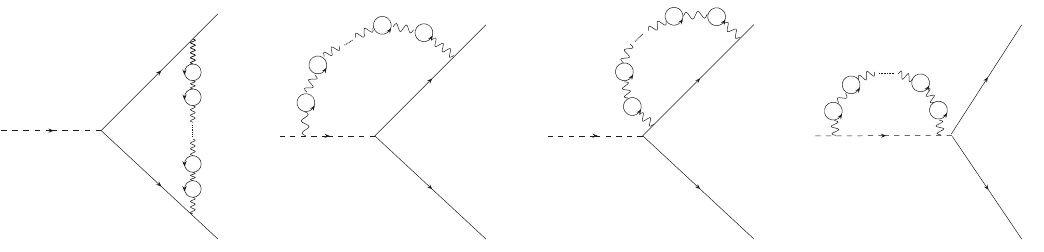
Figure 2 . Dominant contributions to the Yukawa vertex in the limit of large N F